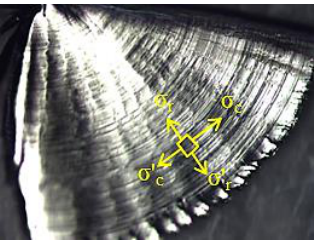
Figure 19. Illustration of stress state on the fan shaped nickel alloy Inconel 625 chip.